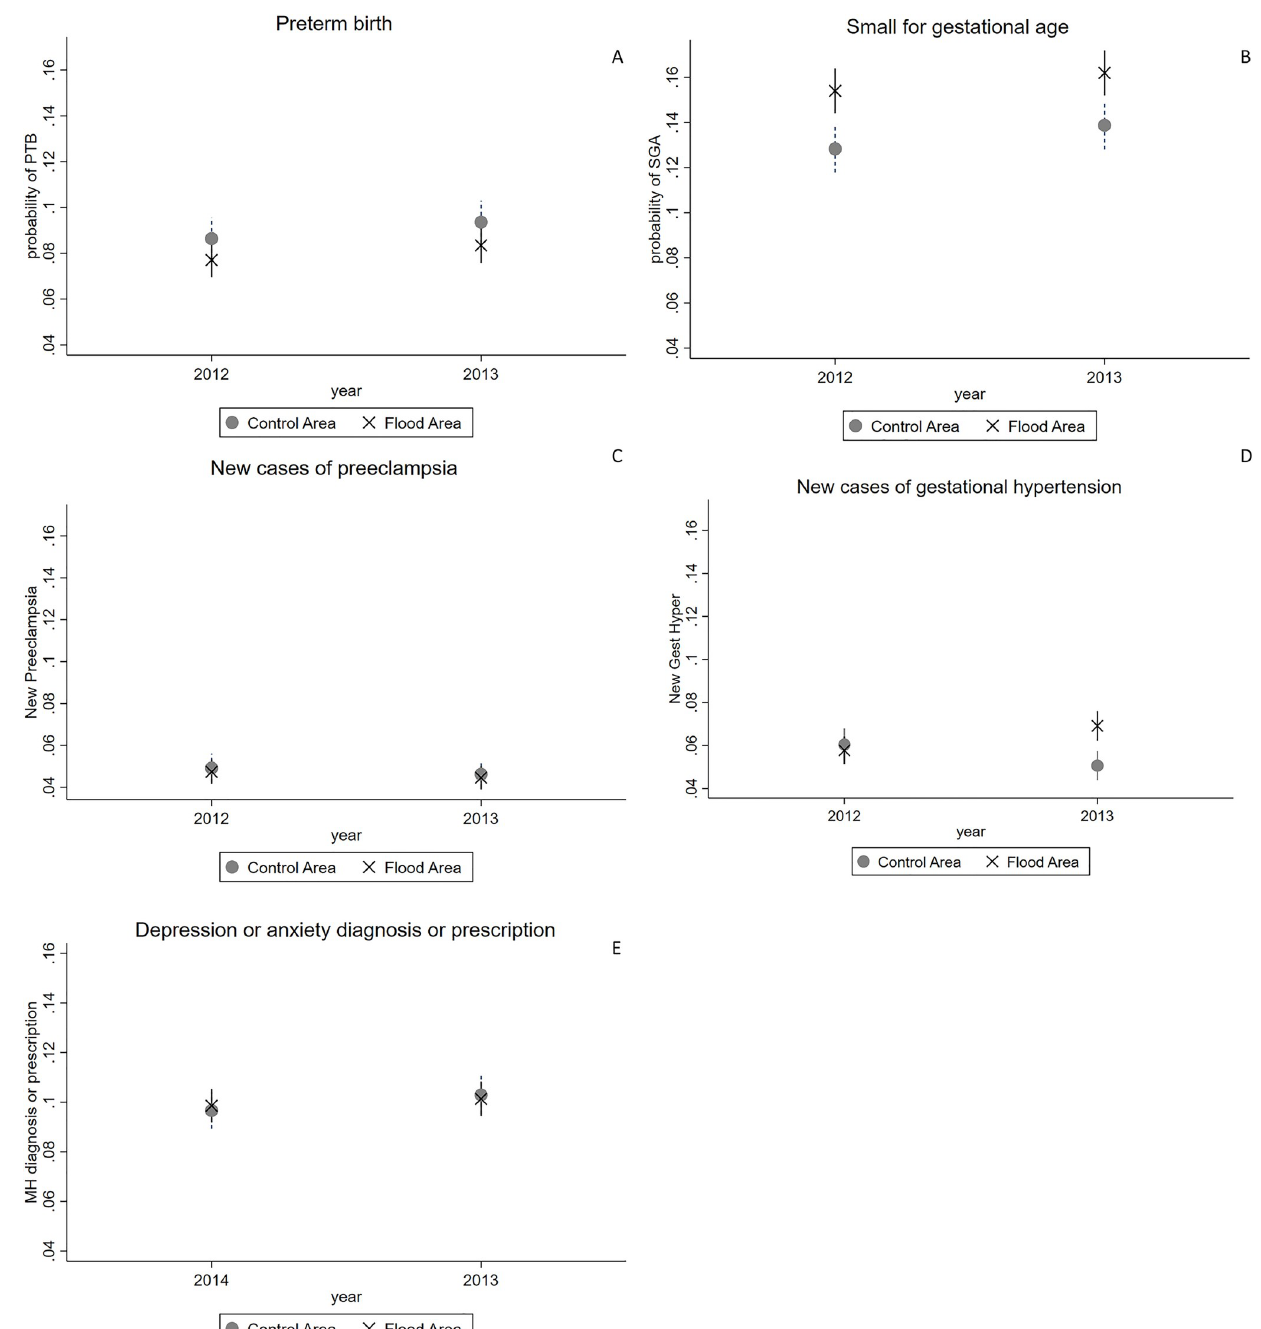
Fig 2. Marginal probabilities of outcomes. Panel A: marginal probabilities of preterm birth in flood and control areas in 2013 and 2012, n = 17224; Panel B: marginal probabilities of small for gestational age in flood and control areas in 2013 and 2012 n = 18291; Panel C: marginal probabilities of new case of preeclampsia in flood and control areas in 2013 and 2012 n = 18291; Panel D: marginal probabilities of new cases of gestational hypertension in flood and control areas in 2013 and 2012 n = 18291; Panel E: marginal probabilities of a diagnosis or prescription for anxiety or depression in flood and control areas in 2013 and 2014 n =